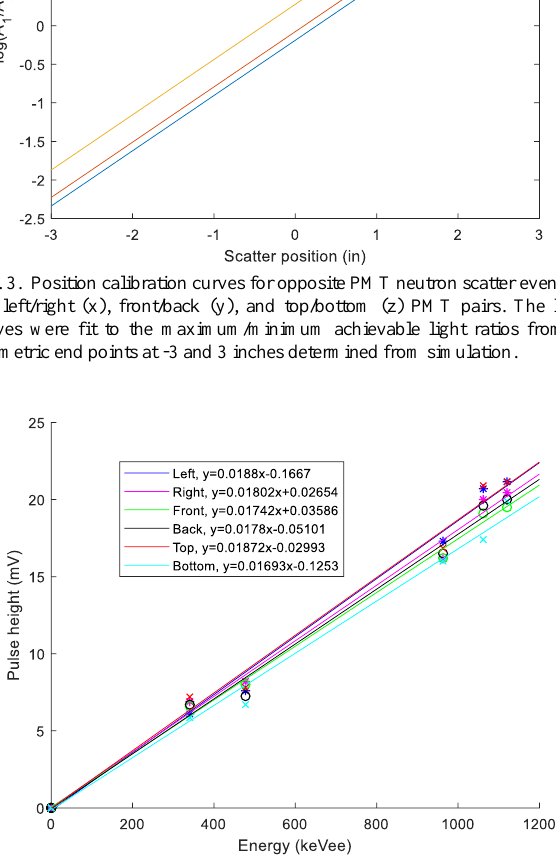
Fig. 4. Linear energy calibration curves for each of the six PMT used in the scatter camera. The five 90% height Compton edge values for each PMT are plotted along with lines of best fit forced to pass through zero.